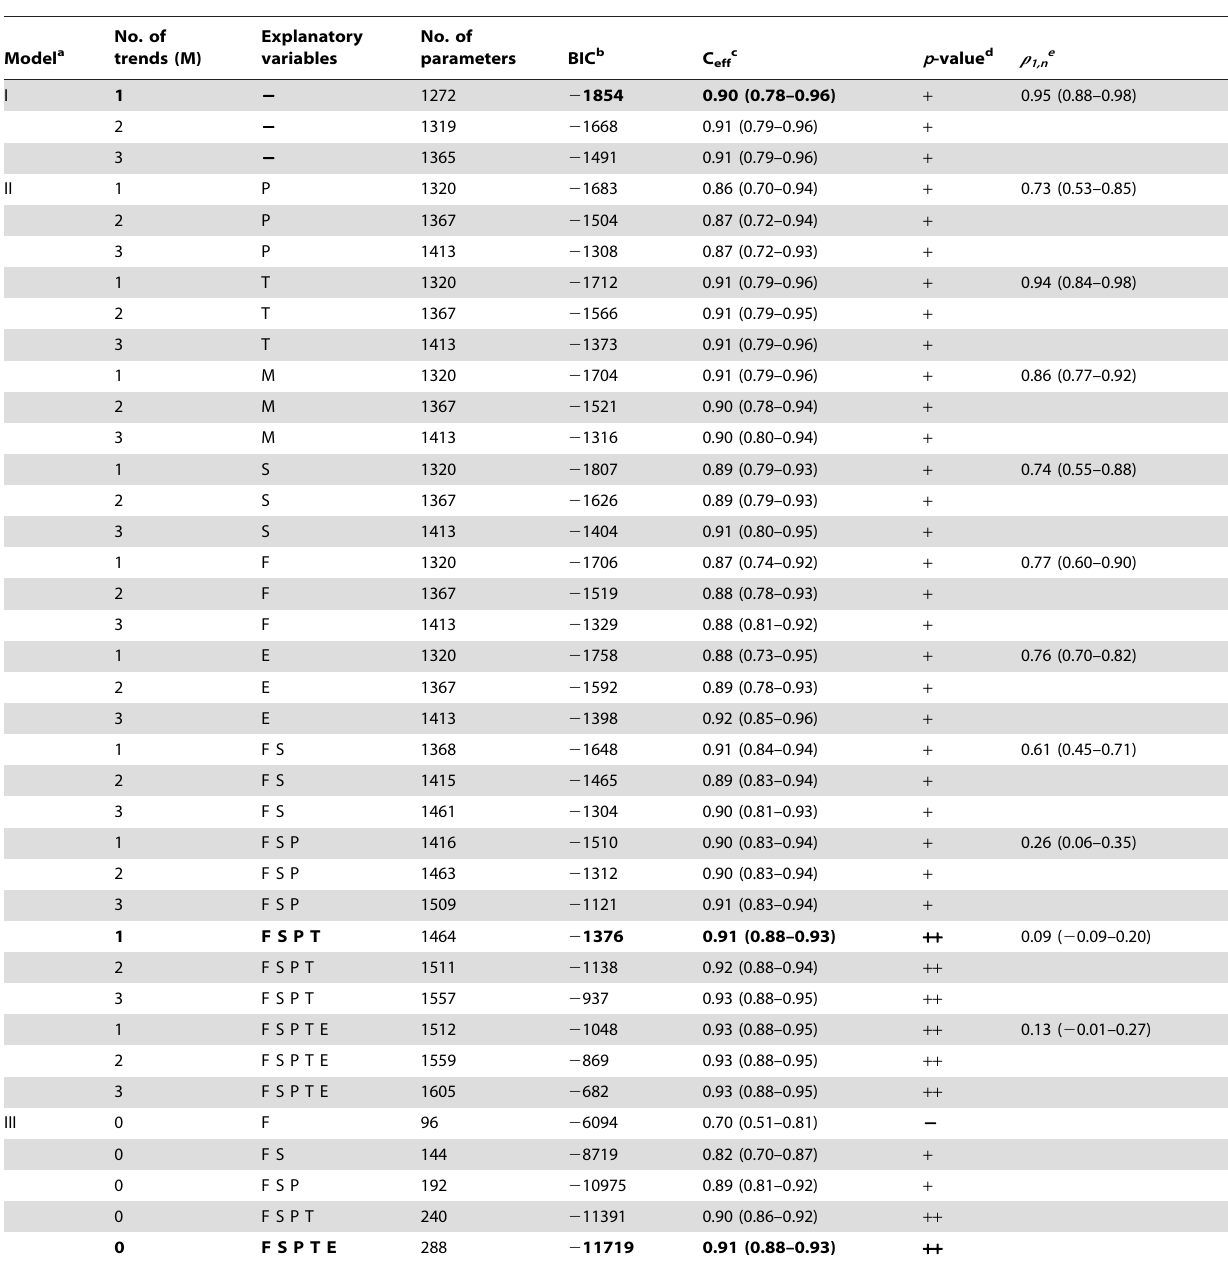
Table 2. Selected results of the dynamic factor analysis of Normalized Difference Vegetation Index (NDVI).